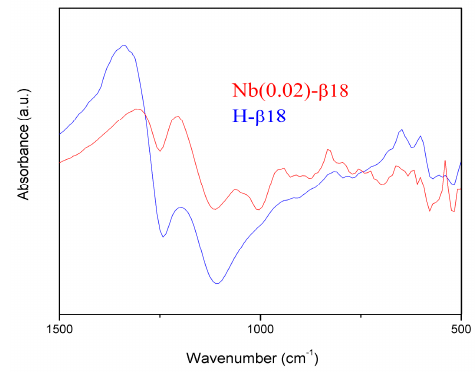
Figure 6. FTIR spectra of H- β 18 and Nb(0.02)- β 18.